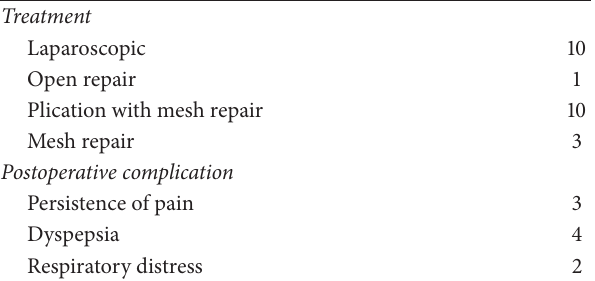
Table 4: Treatment option and complications.